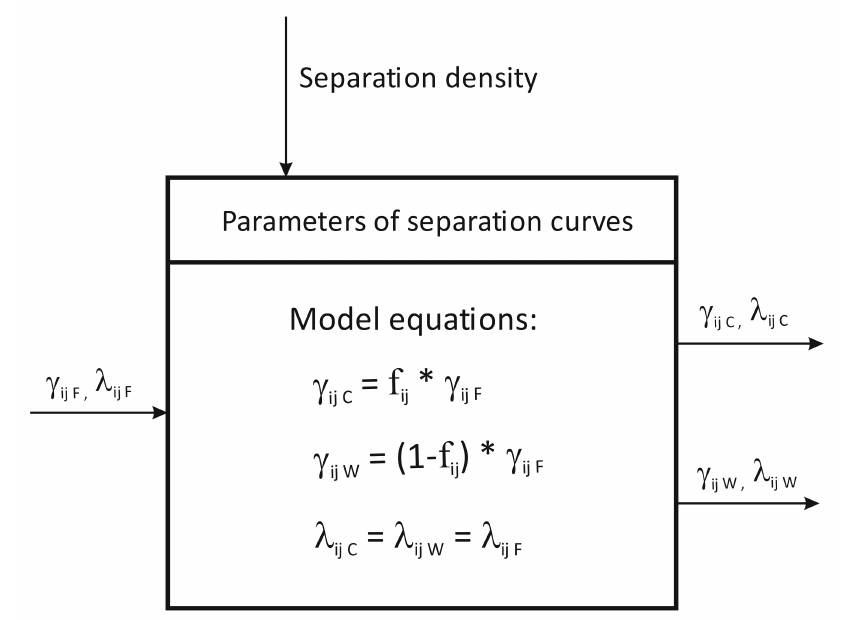
Figure 3. Mathematical model of gravity